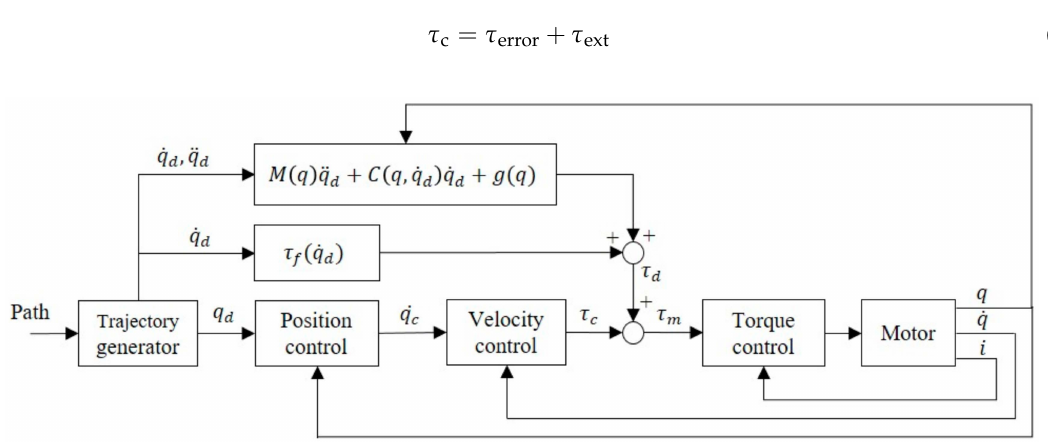
Figure 2. Dynamic compensation control